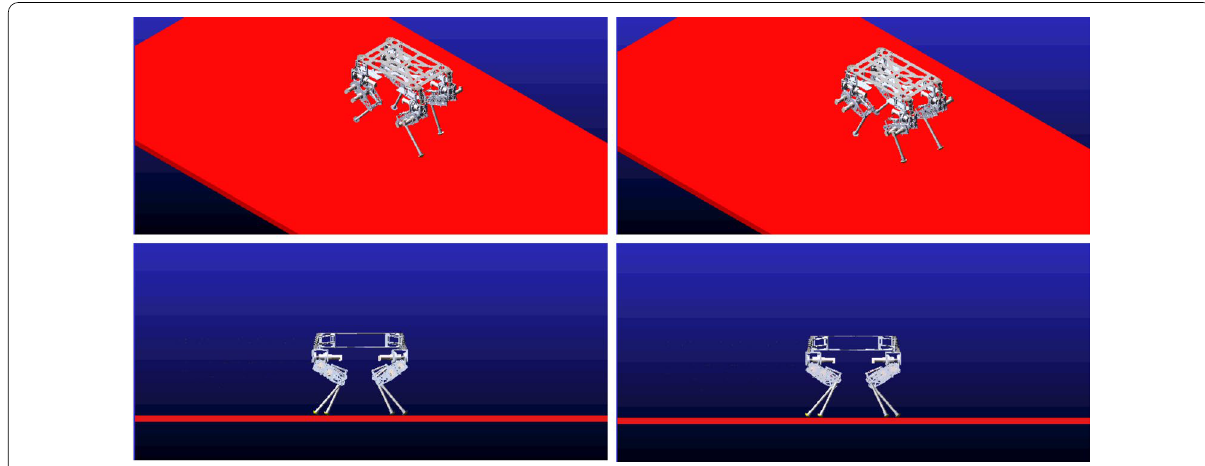
Figure 25 Trotting gait simulation of a quadruped